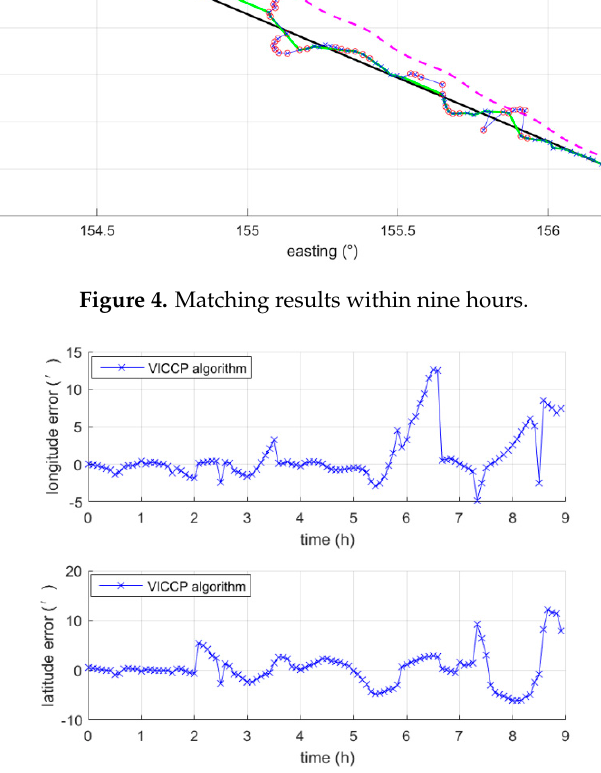
Figure 5. Longitude error and latitude error within nine hours.